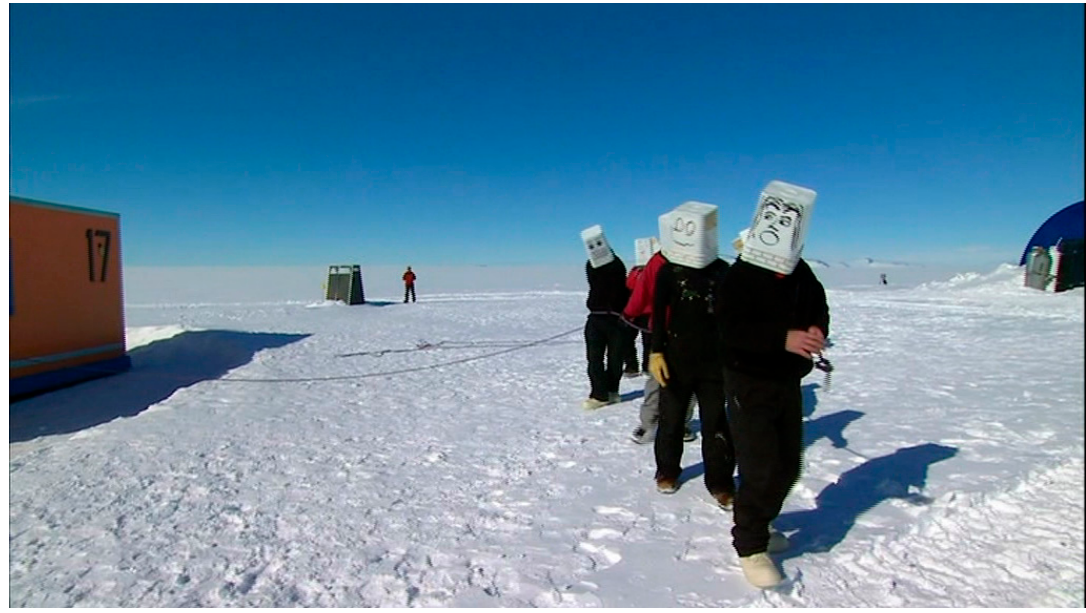
Figure 3. The “bucket-head whiteout scenario”.